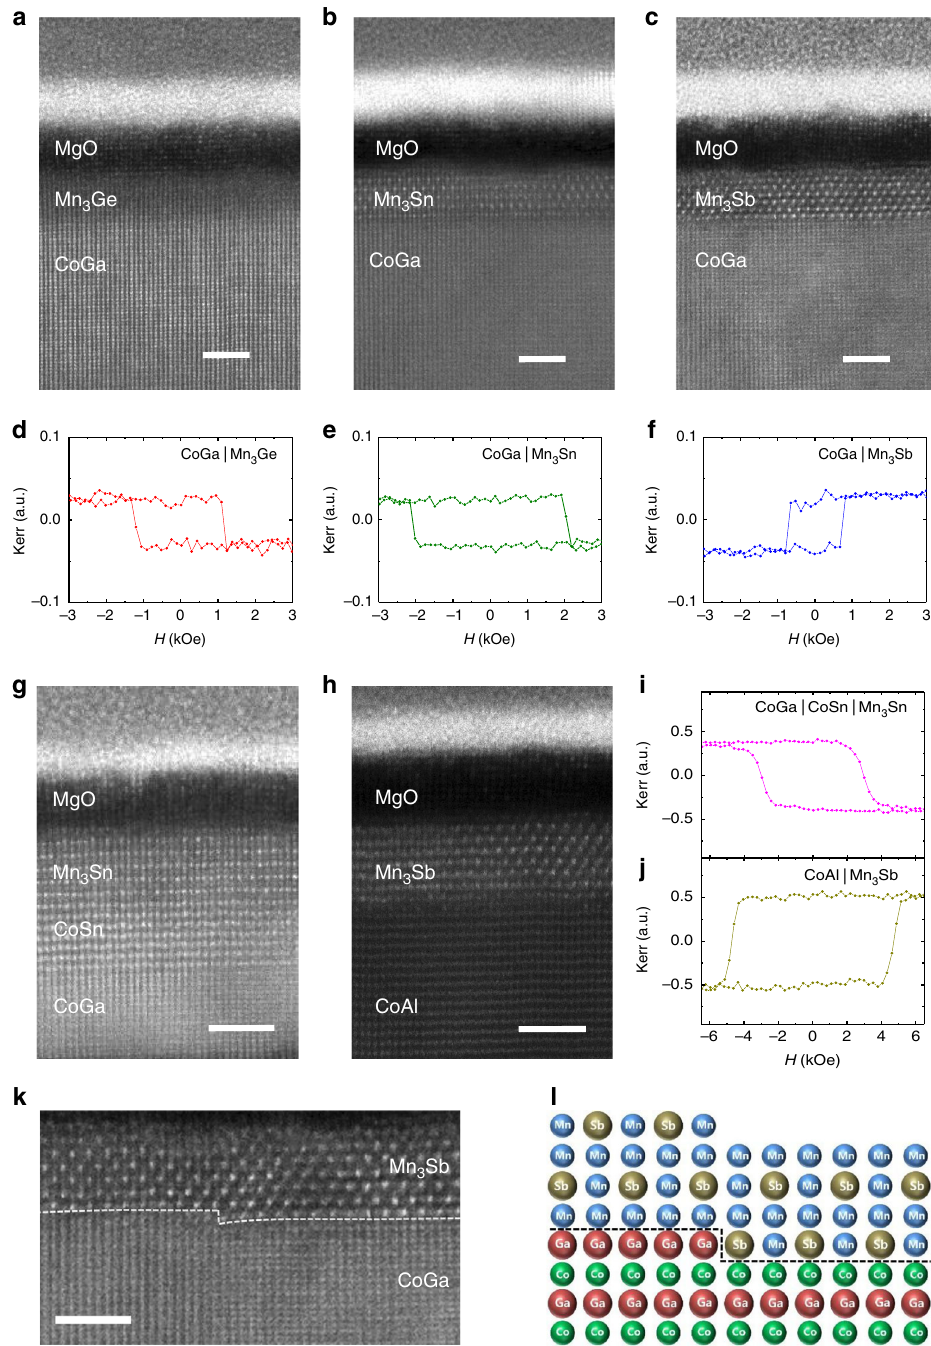
Fig. 2 TEM images of Mn 3 Z (Z = Ge, Sn, Sb) on CoGa, CoSn, CoAl CTLs. HAADF STEM images of ( a ) Mn 3 Ge, ( b ) Mn 3 Sn, and ( c ) Mn 3 Sb Heusler fi lms on CoGa CTL. The Heusler fi lms were 2 nm thick and deposited at ambient temperature. Corresponding P-MOKE hysteresis loops are displayed in ( d ), ( e ), and ( f ), respectively. HAADF STEM images of ( g ) 2 nm-thick Mn 3 Sn on CoGa|CoSn CTL and ( h ) 2 nm-thick Mn 3 Sb on CoAl CTL with their corresponding P-MOKE hysteresis loops in ( i ), ( j ) respectively. An example of the growth of a 20 Å-thick Mn 3 Sb layer across a step in the CTL is shown in ( k ). The STEM image is taken along the [110] axis of the CTL (Mn 3 Sb [100]). The slight bending of the atomic planes is due to specimen charging during TEM measurements. A corresponding schematic illustration is shown in ( l ). Scale bars denote 2